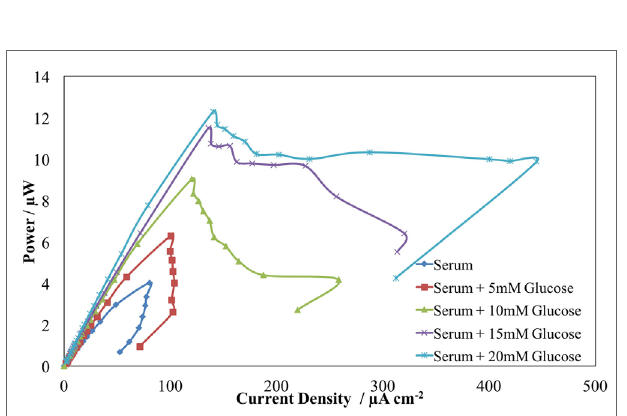
FigUre 7 | Temperature dependence of the power output of the biofuel cell operating in human serum at rT (blue) and 37°c (red)